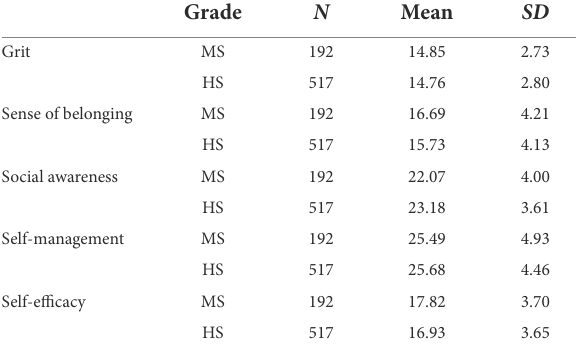
TABLE 5 Difference between groups based on grade